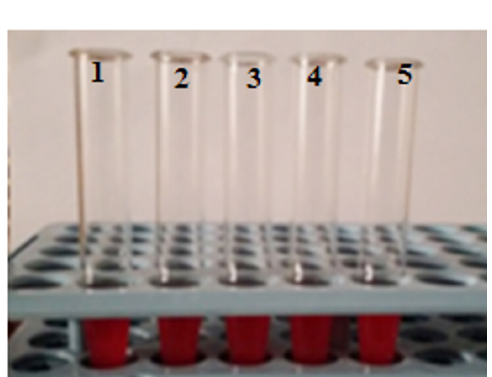
Fig. 2. Cytotoxicity assay indicated that Myristica fragrans alkaloid extract have no cytotoxicity effect against different concentrations of human blood solution during 15, 30 and 60 min. at room temperature (1= 200 ppm, 2=100 ppm, 3=50, 4=10 ppm and 5= control tube)